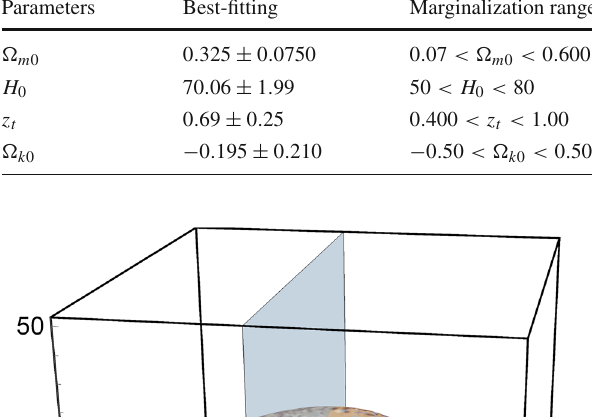
Table 1 Best-fitting parameters 1 σ confidence intervals Parameters